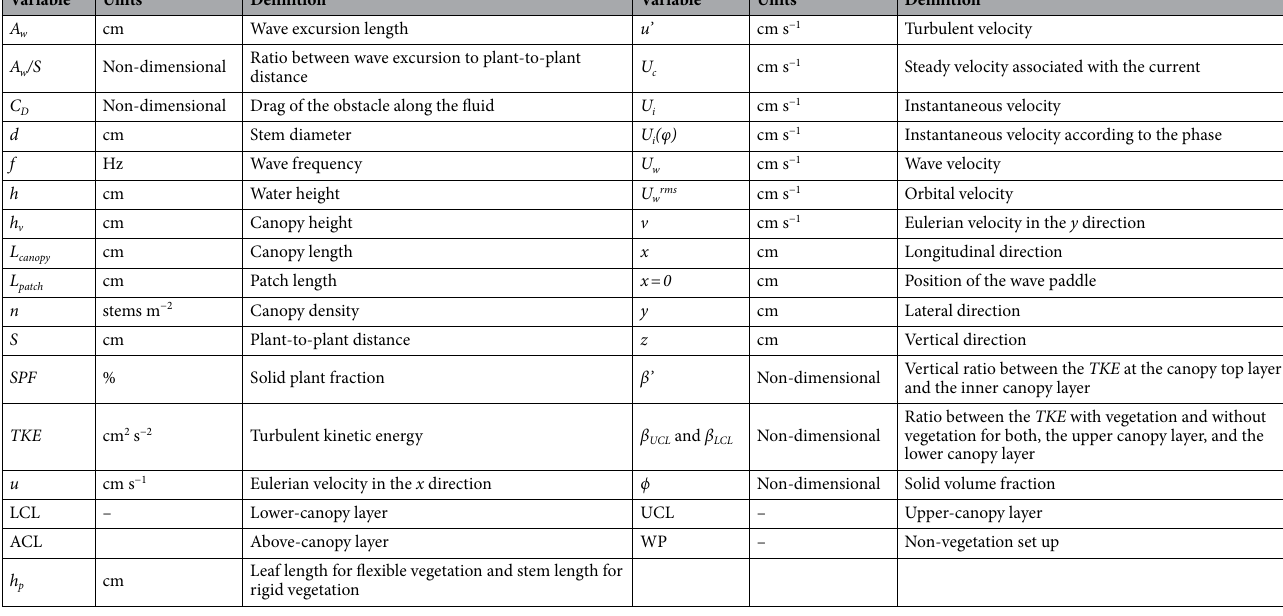
Table 1. Nomenclature